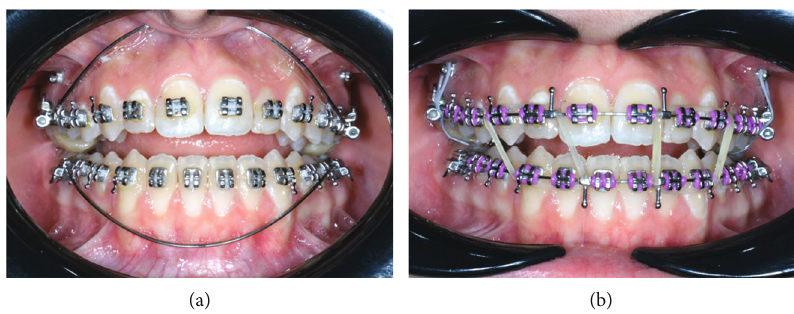
Figure 4: (a) Passive NiTi curved arches; and (b) anterior vertical